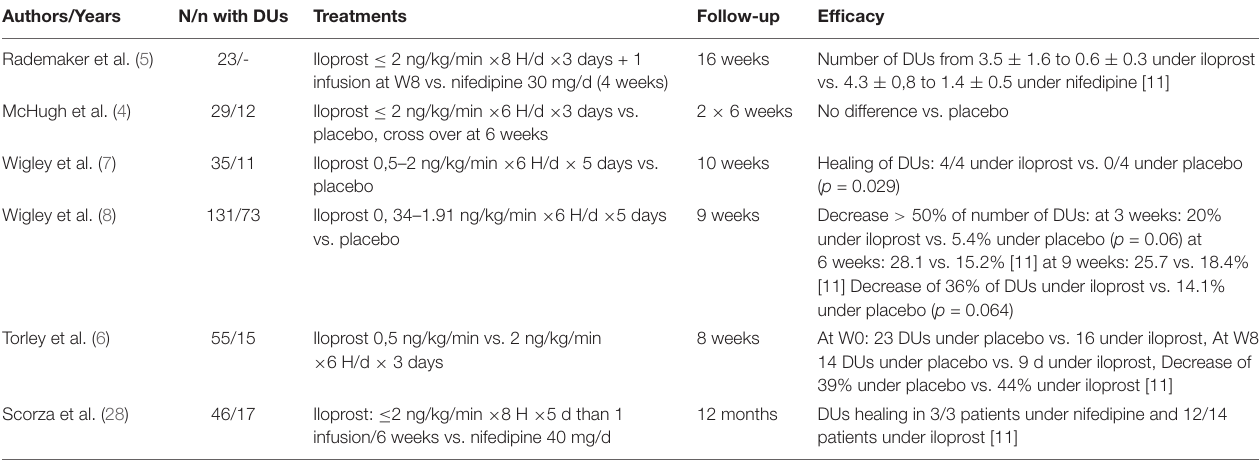
TABLE 3 | Literature review of randomized trials using iloprost for DUs in systemic sclerosis. Authors/Years